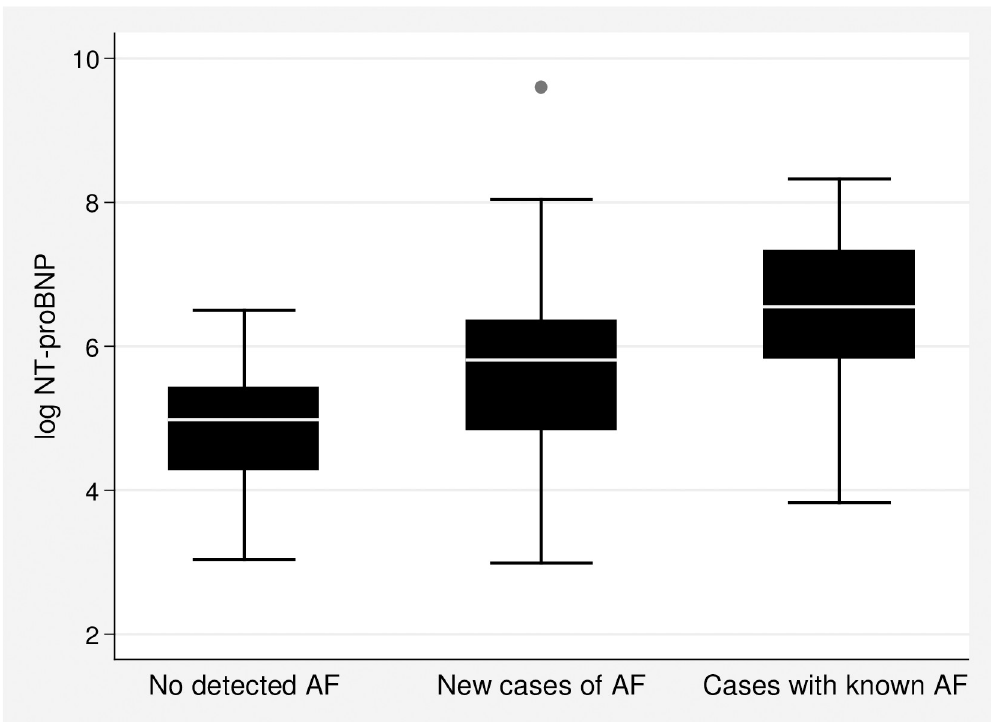
Fig 2. Box-plot showing natural logarithm-transformed NT-proBNP values for different AF groups.